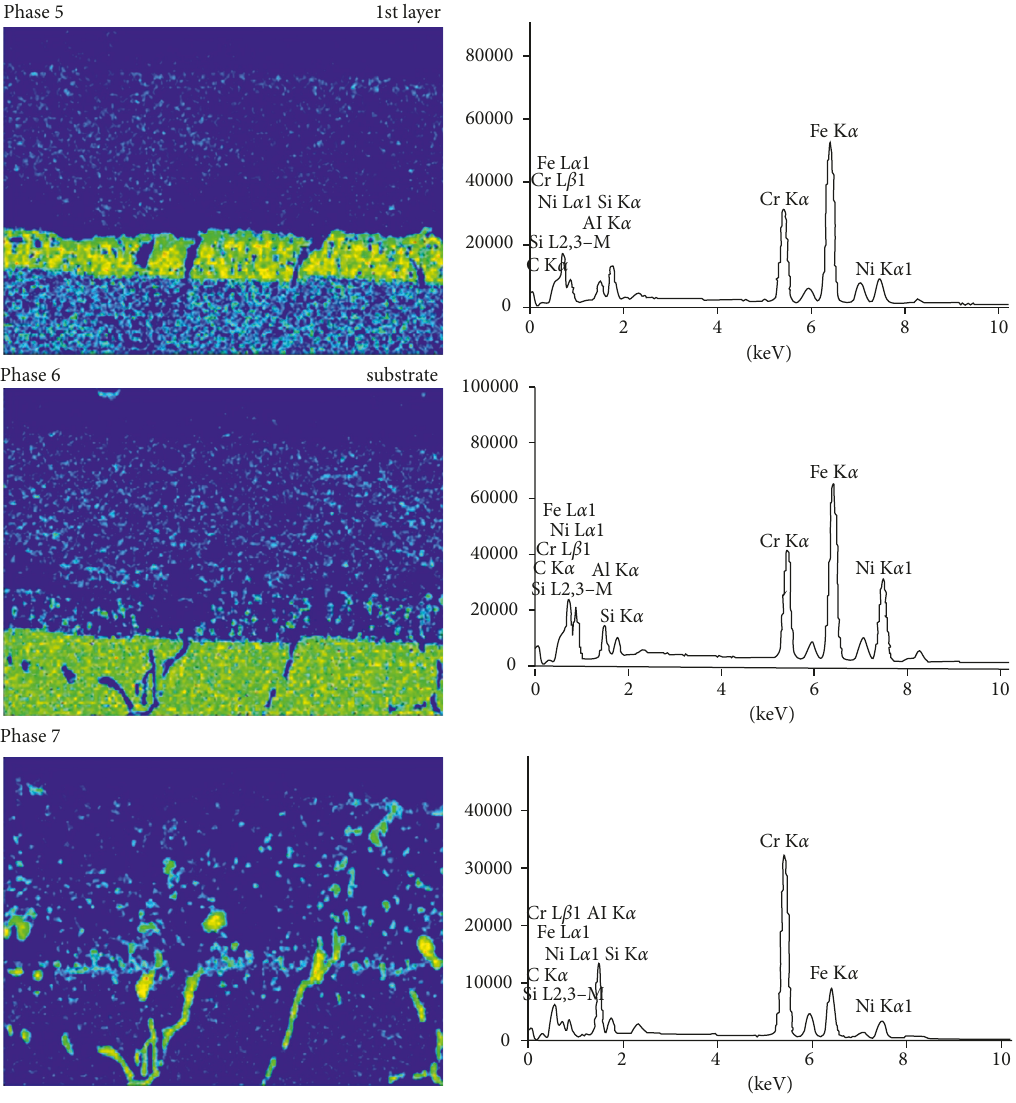
Figure 7: Mapping of phase components (according to Figure 5) with cumulative EDS